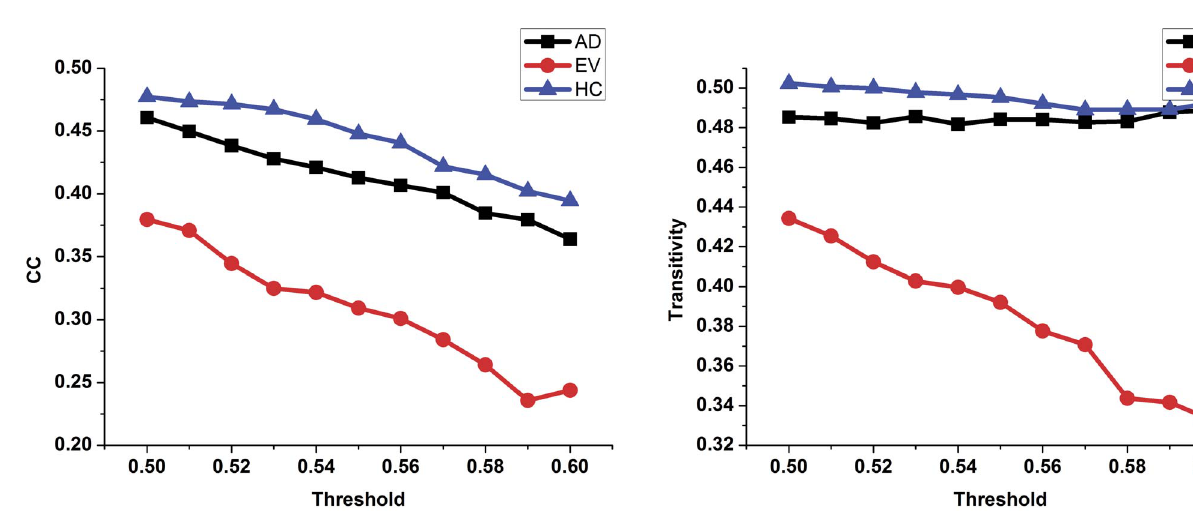
Figure 5. The clustering coefficient of the functional brain network of the healthy controls, AD patients and evolution under different thresholds. Blue triangle represents the healthy control group, black rectangle represents the group of patients with AD, the red dot represents the evolution network group.